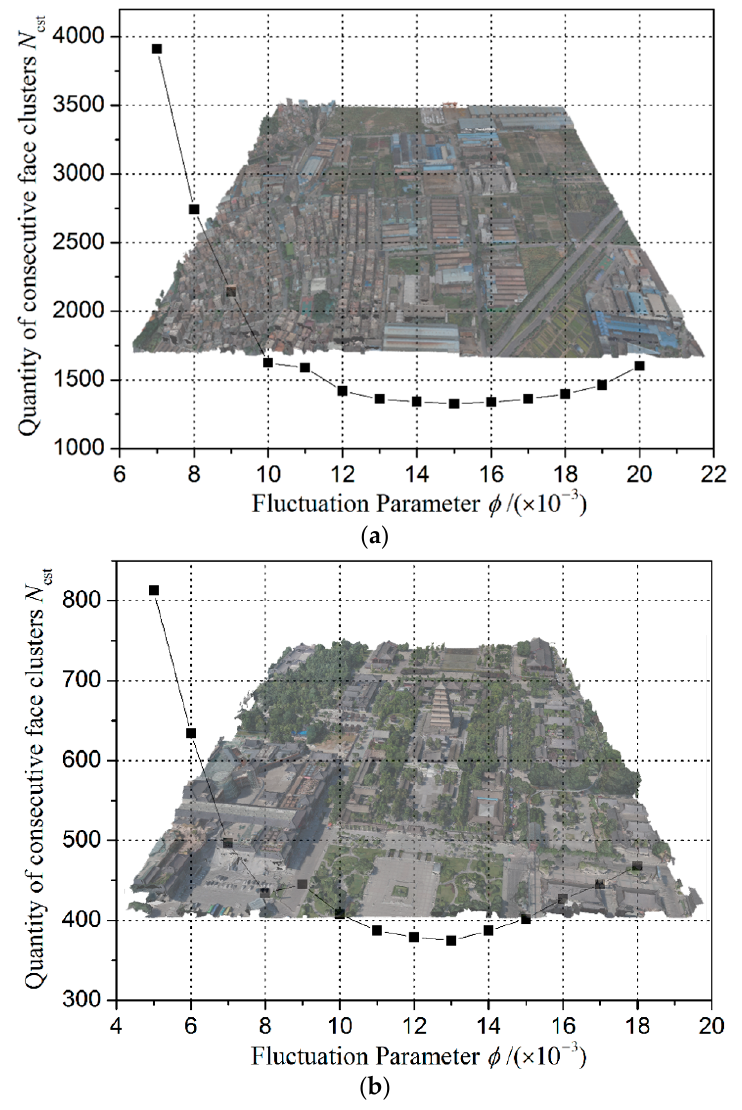
Figure 4. As expected, φ that corresponds to the minimum Q C is located in the second quasi-zero interval in Figure 3. This dual mechanism used to find ε φ is conducive to identifying the outlier of the judgment that ε φ is not located in the second quasi-zero interval. ( a ) Scenery 1; ( b ) Scenery